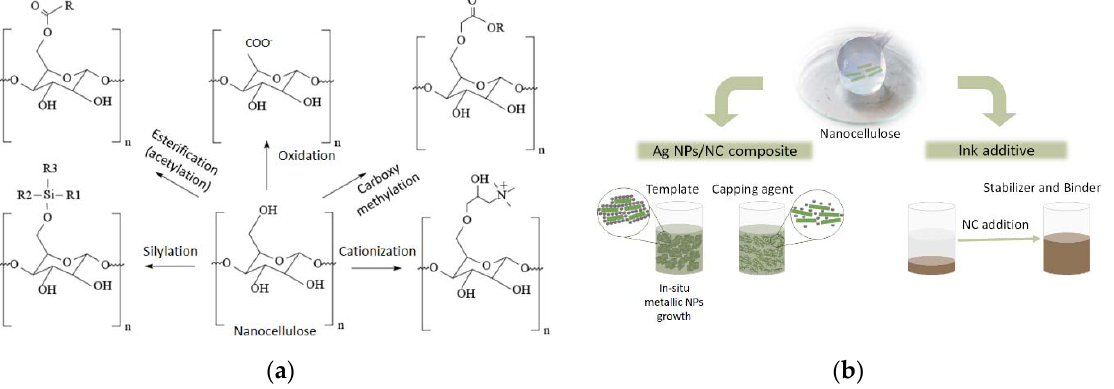
Figure 1. ( a ) Scheme of common modification reactions of NC. ( b ) Scheme of NC properties suitable for conductive composites and inks .